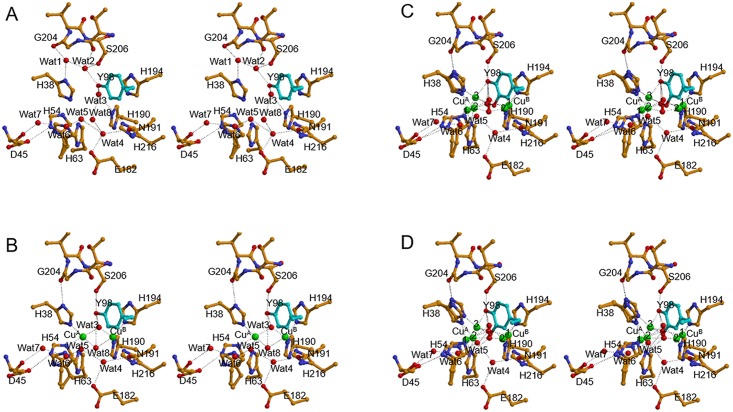
Structural models around the catalytic site of tyrosinase complexed with the caddie protein.(A) Cu(II)-free form. (B) met2 form. (C) ST3. (D) ST5. Wat5, Wat6, and Wat8 are not completely occupied in (A), whereas Wat5 and Wat6 are not in (B). In (C) and (D), peroxide and Wat3 are present between CuA and CuB. D, aspartic acid; E, glutamic acid; G, glycine; H, histidine; N, asparagine; S, serine; Wat, water molecule; Y, tyrosine.